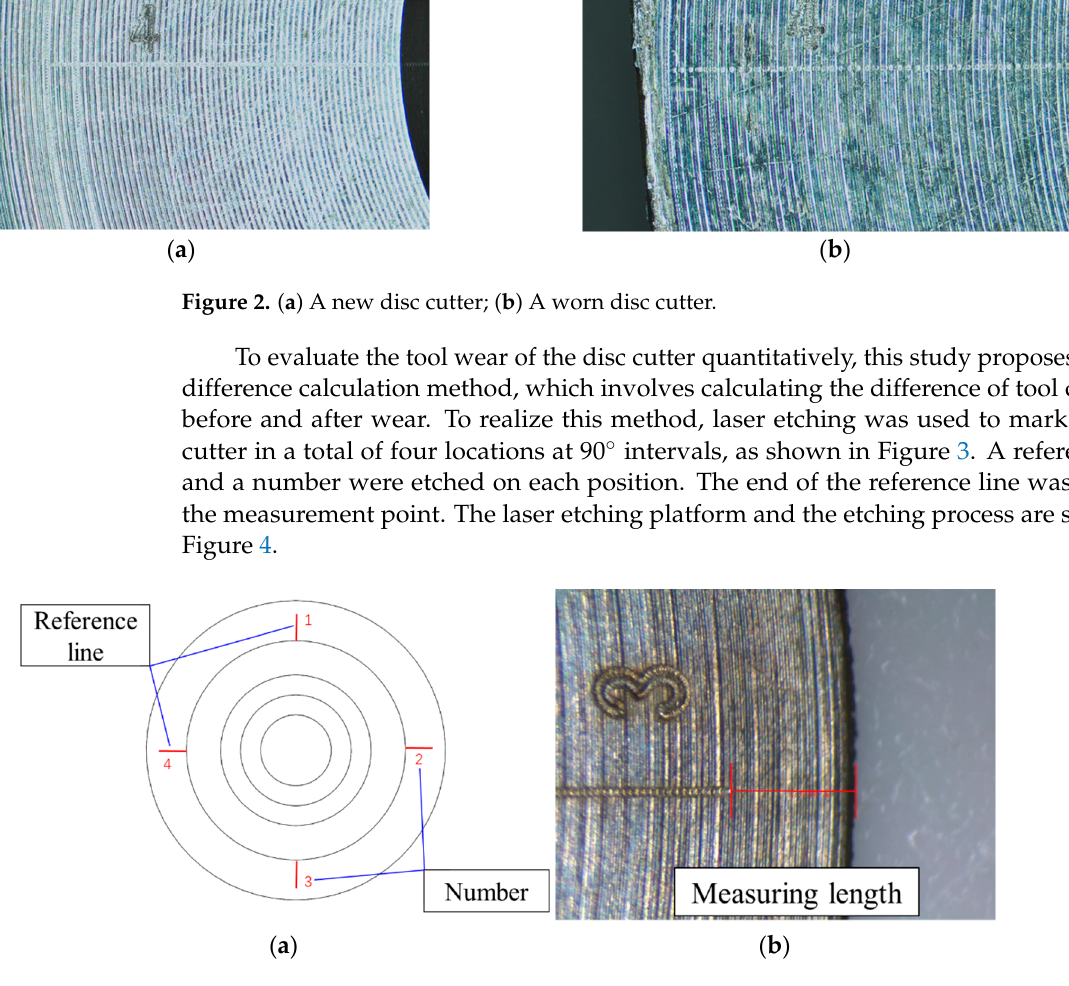
Figure 4. The laser etching platform. As shown in Figure 5, when observing the tool wear, the number is first found by microscope at a low magnification, and then the line is found at a high magnification as a reference to observe the tool wear. The distance between the edge of the disc cutter and the end of the reference line is measured. Finally, the radial difference is calculated as the value of the tool wear. This method is called the radial difference calculation method (RDC). During the experiments, the tool wear at set intervals was observed and the radial difference recorded so as to explore the rule of conduct of the tool wear.